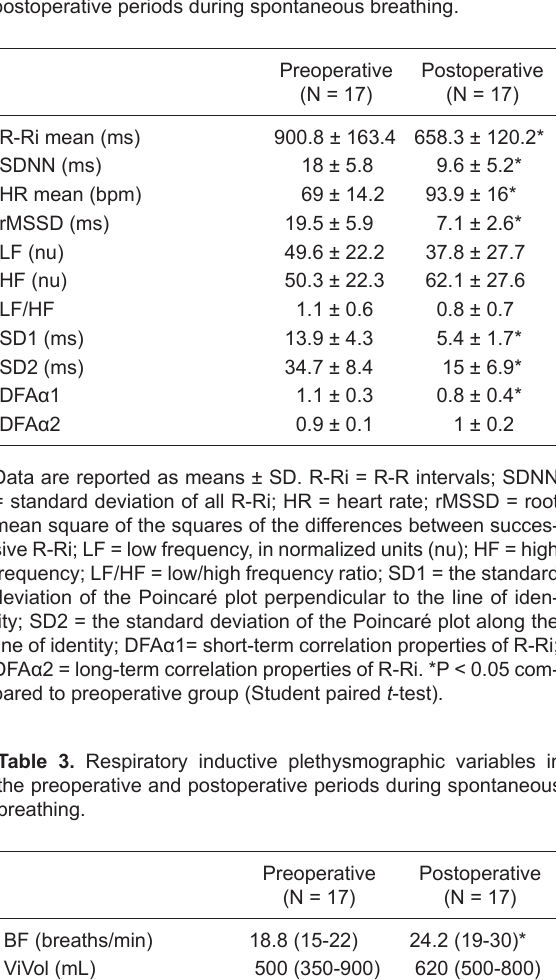
Table 2. Heart rate variability variables in the preoperative and postoperative periods during spontaneous breathing.